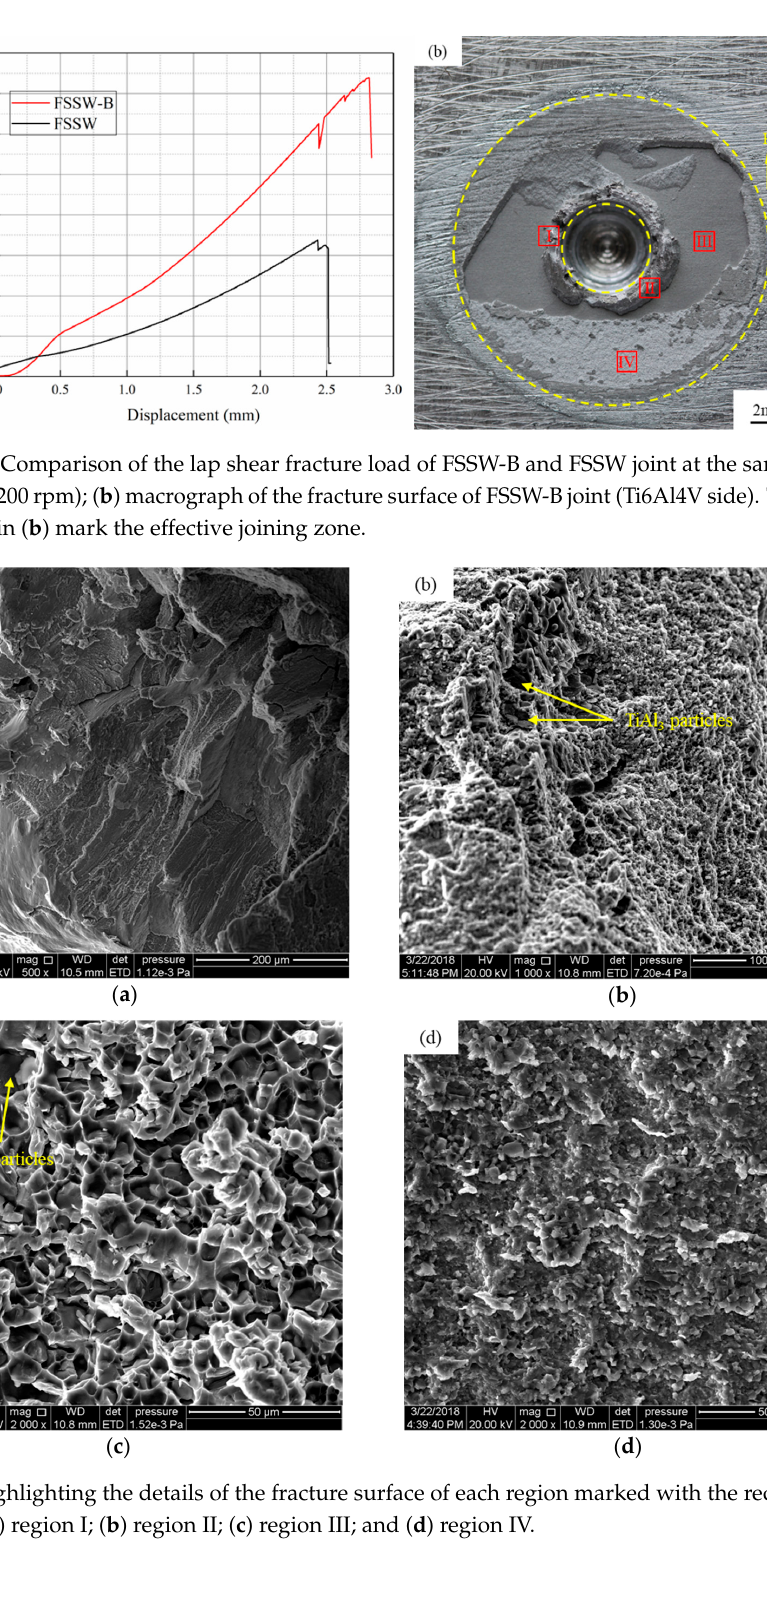
Figure 7. ( a ) Comparison of the lap shear fracture load of FSSW-B and FSSW joint at the same process parameter (1200 rpm); ( b ) macrograph of the fracture surface of FSSW-B joint (Ti6Al4V side). The yellow dotted lines in (b) mark the effective joining zone.